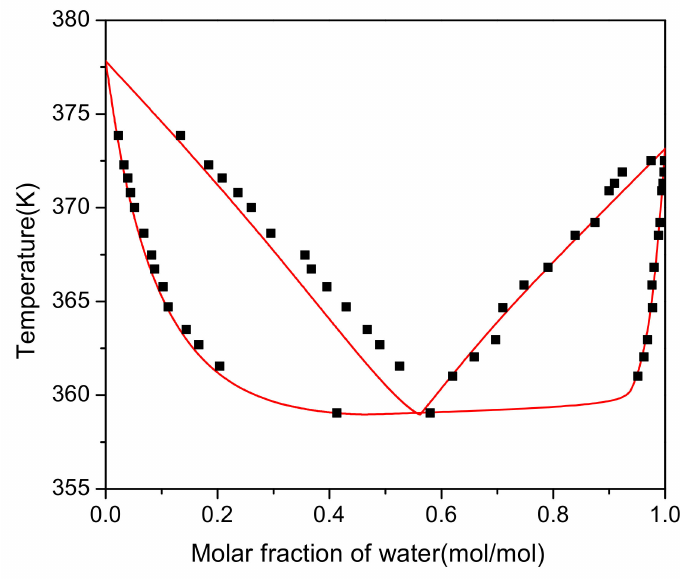
Figure 3. Vapor–liquid equilibrium diagram. ( ▅ Experimental results. Lines: